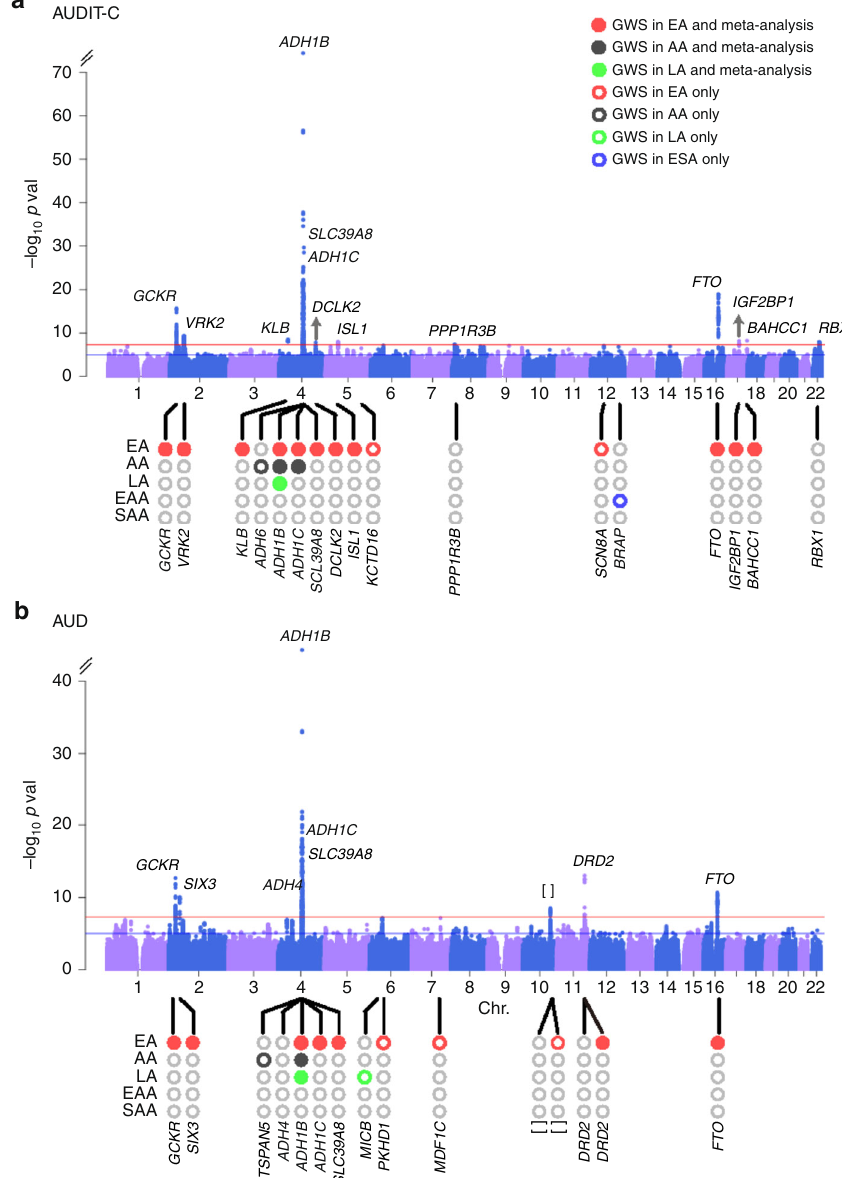
Fig. 1 Manhattan plots for age-adjusted mean AUDIT-C score and AUD diagnosis. a Manhattan plot of the genome-wide association meta-analysis of AUDIT-C across all fi ve populations ( N = 272,842). b Manhattan plot of the genome-wide association meta-analysis of AUD across fi ve populations (55,584 cases and 218,807 controls). Red lines show the genome-wide signi fi cance level (5.0×10 − 8 ). EA: European American, AA: African American, LA: Hispanic or Latino, EAA: East Asian American, SAA: South Asian American. Labeled genes at the top of the peaks indicate completely independent signals after conditional analysis in meta-analysis. Population-speci fi c loci are labeled at the bottom of the circles in the lower part of each fi gure. []: no genes within 500kb to the lead The GWAS fi ndings largely re fl ect male-speci fi c signals due to The GWAS for AUD (Fig. 1b, Table 2 and Supplementary the predominantly male sample (Supplementary Table 1). How- Tables 1 and Supplementary Data 2) identi fi ed 10 independent ever, sex-strati fi ed GWAS also identi fi ed two female-speci fi c loci in EAs, 2 in AAs, and 2 in LAs (Supplementary Figs. 6, 7). signals for AUDIT-C (Supplementary Data 3, Supplementary Meta-analysis across the fi ve populations yielded 10 independent Figs. 9, 10) and one for AUD (Supplementary Data 4, loci, including 3 previously associated with alcohol dependence 25 — ADH1B , ADH1C , and ADH4 — and 7 loci not previously Supplementary Figs. 11, 12). associated with an AUD diagnosis: GCKR , SIX3 (SIX Homeobox For AUDIT-C, when associations for the seven LD-pruned 3) , SLC39A8 , DRD2 (Dopamine Receptor D2: rs4936277 and GWS SNPs on chromosome 4q23 – q24 in EAs are conditioned rs61902812, which were independent), chr10q25.1 (rs7906104), on rs1229984, the most signi fi cant functional SNP in the and FTO . Five loci were signi fi cant in both the AUDIT-C and region in that population, the only independent signal (using a AUD GWASs (Supplementary Fig. 8): ADH1B , ADH1C , FTO , Bonferroni-corrected p value < 0.05) is for rs1229978, near GCKR , and SLC39A8 . The trans-population GWS fi ndings for ADH1C (Supplementary Data 5). For AUD, when associations AUD are also driven largely by the fi ndings in EAs. for the four LD-pruned GWS SNPs in EAs are conditioned on